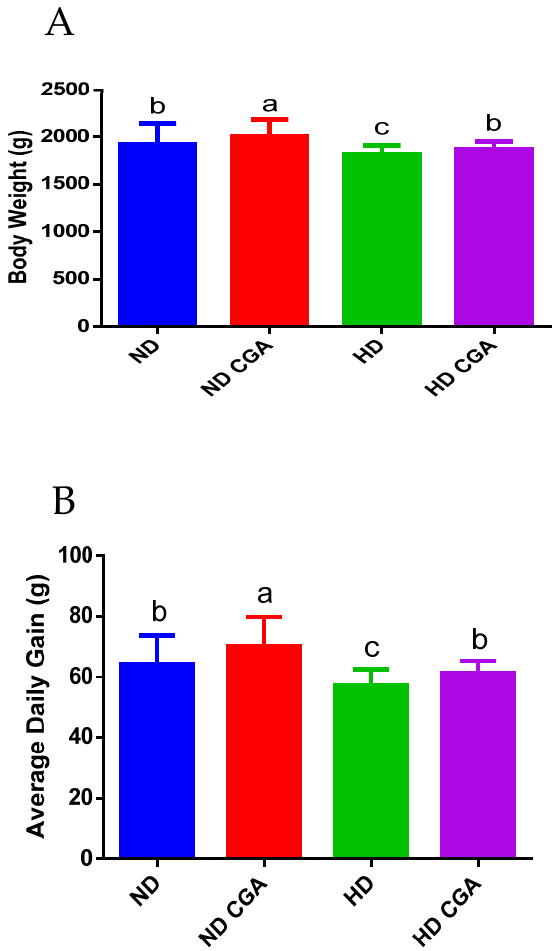
Figure 1. Effects of CGA on growth performance of broilers under HD stress. ND group, normal stocking density + basal diet; ND + CGA group, normal stocking density + basal diet + 0.15% CGA; HD group, high stocking density + basal diet; HD + CGA group, high stocking density + basal diet + 0.15% CGA. ( A ) Body weight at day 42. ( B ) Average daily gain at days 21 and 42. Each vertical bar represents the mean ± SEM (n = 10). Values with different letters are significantly different ( p < 0.05, Tukey’s HSD test after one-way ANOVA).